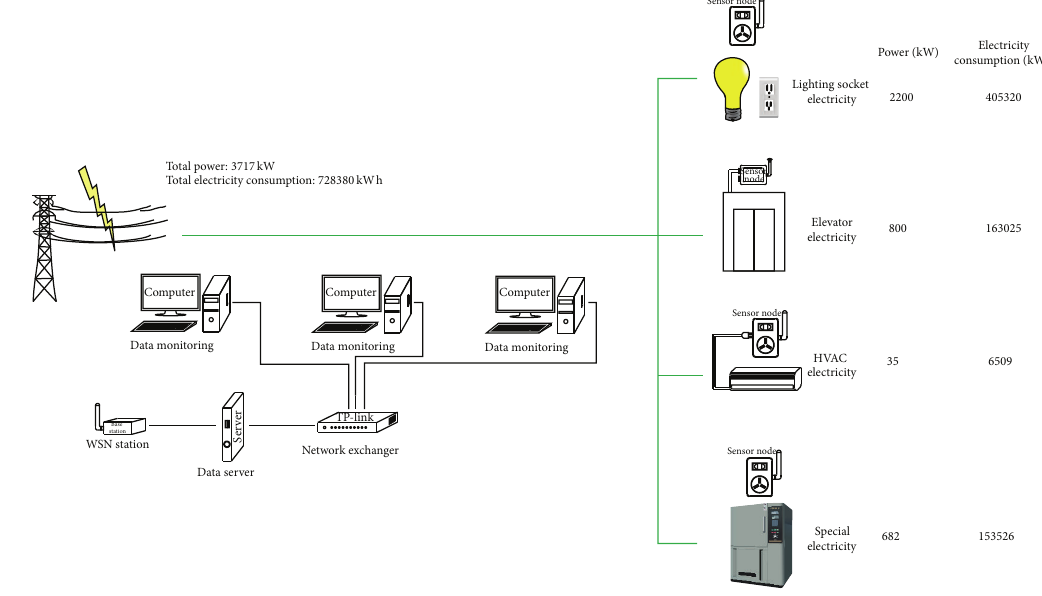
Figure 16: Subentry metering of building energy by ZBEMCS.